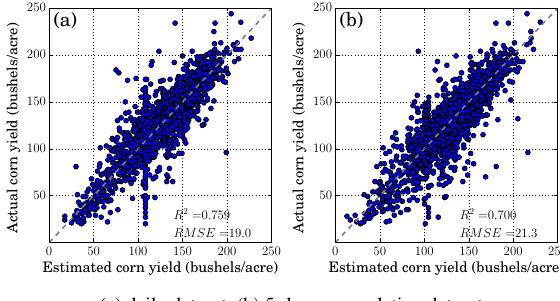
Figure 10: Corn yield estimation with an autoencoder